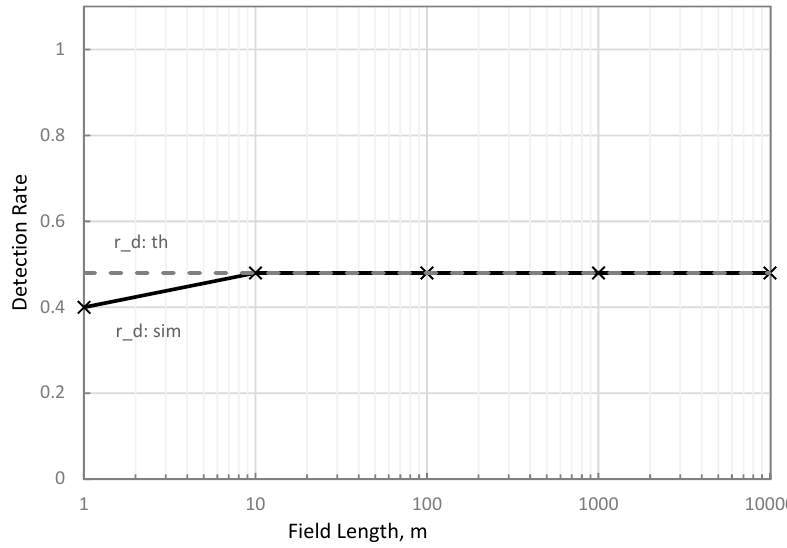
Figure 7. Theoretical (solid) and simulated (broken-line) detection rates at 1, 10, 100, 1000, and 10,000 m field lengths at 0.2 m hill spacing, 2.5 m/s travel velocity, 2.4 fps, and 0.5 m frame capture width.